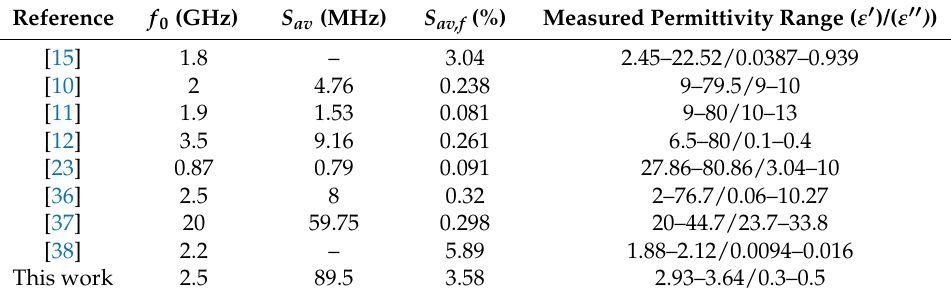
Table 2. Comparison of various sensors in terms of